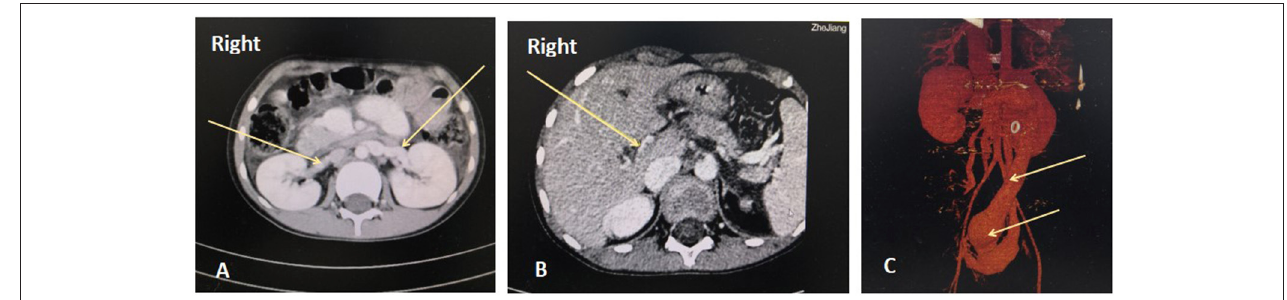
FIGURE 1 | Abdominal enhanced computed tomography angiography (CTA). A. Bilateral renal veins are enlarged and thickened. B. The right branch of the portal vein is extremely thin, with a diameter of 1.2mm. The left branch and the junction are not apparent in the images. C. The inferior vena cava and pelvic vein are remarkably dilated, and the widest point is 41 mm.